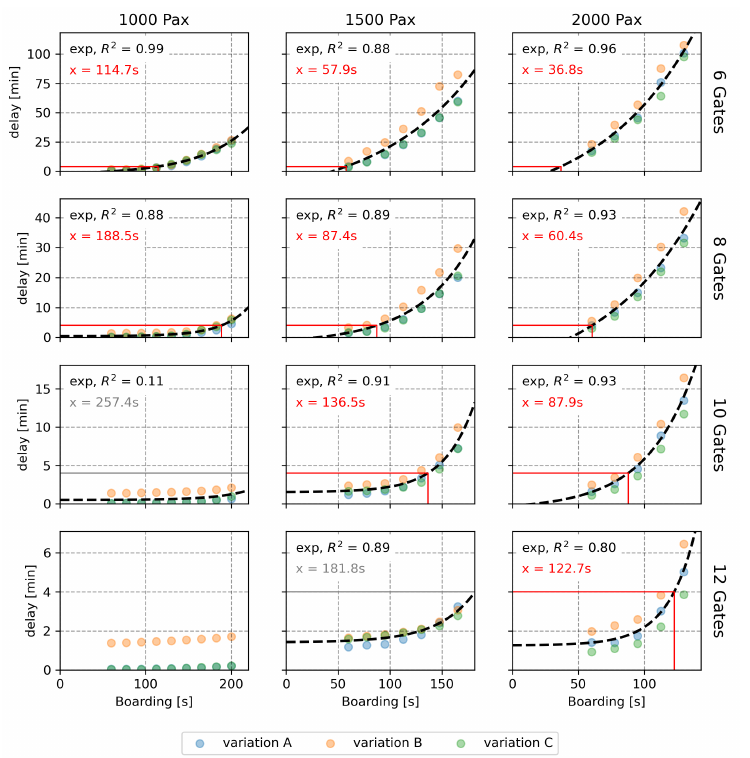
Figure 12. Simulation study under variation of demand, number of gates and boarding and de- boarding